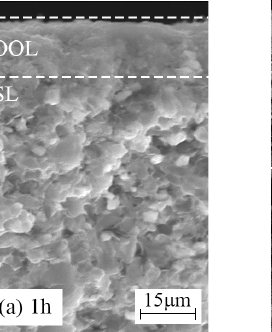
Figure 7. Fracture morphologies of TBHB at 1100 °C in different oxidation times: ( a ) 1 h, ( b ) 4 h, ( c ) 7 h, ( d ) 10 h.